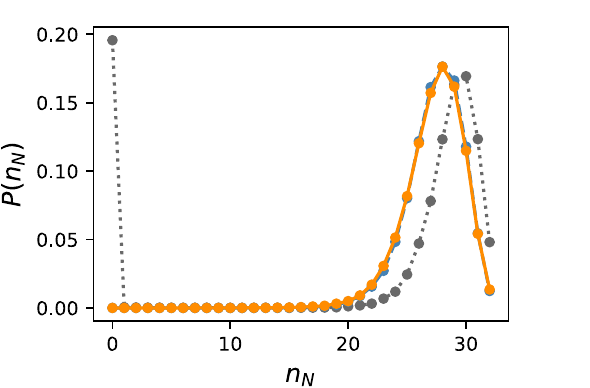
Fig 5. Distribution of the number of effective nodes n . The data for f 2 [0.99, 1.0] are shown. If a node has at least N one path to the output node, the node is regarded as “effective.” The orange solid line represents Evo50, the blue dashed line represents random sampling, and the grey dotted line represents random networks as a reference. The distribution for the ES was corrected using the reweighting method described in the text.